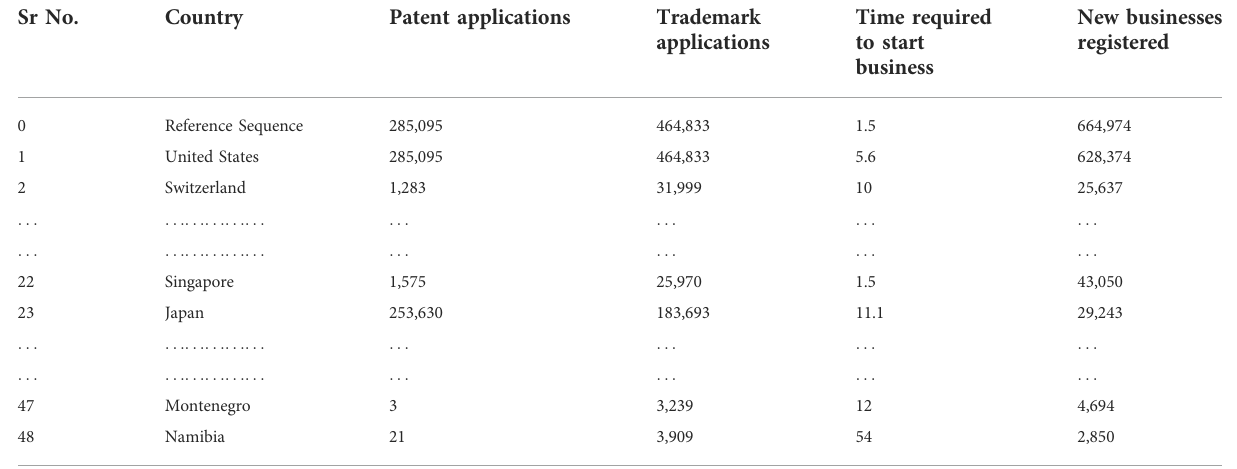
TABLE 3 Reference sequence and comparable sequences. Sr